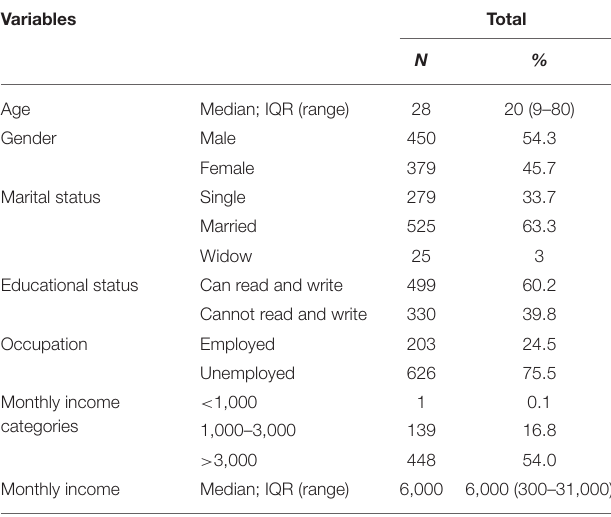
TABLE 1 | Baseline characters of participants ( N = 829